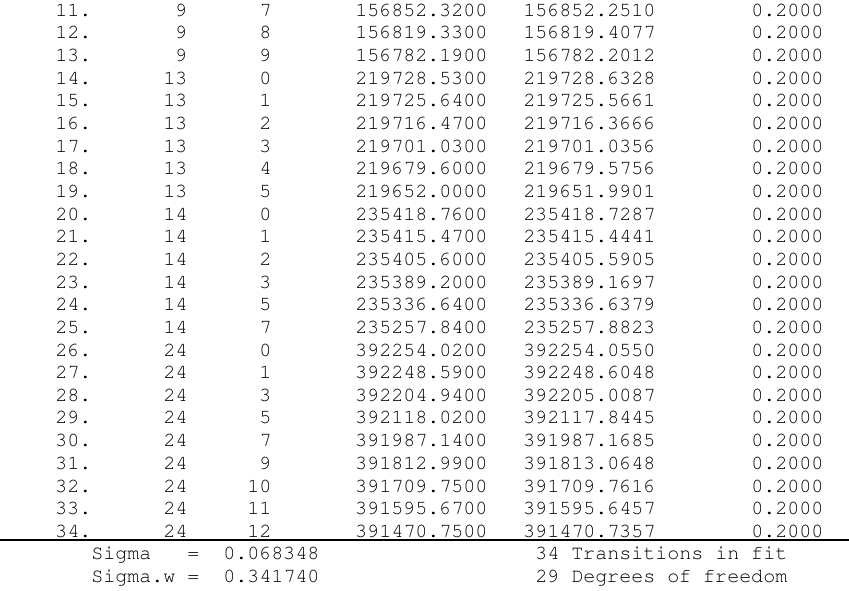
C 15 N in the ground state 22,25 3